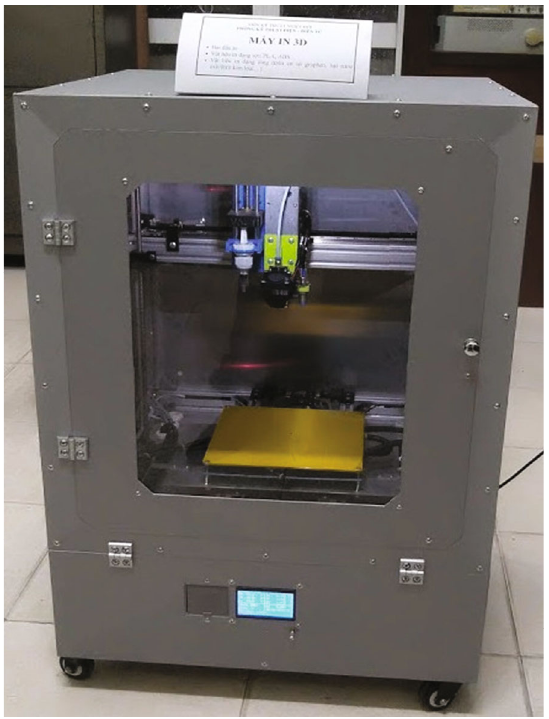
Figure 1: 3D printing device